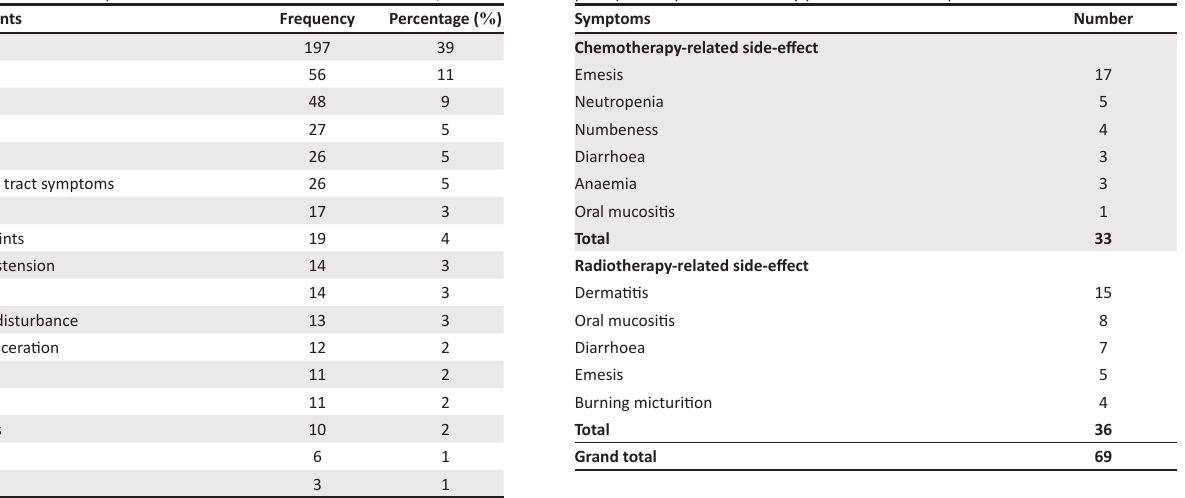
TABLE 4: Breakdown of symptoms secondary to cancer treatments that prompted unplanned visits by patients to the outpatients unit.